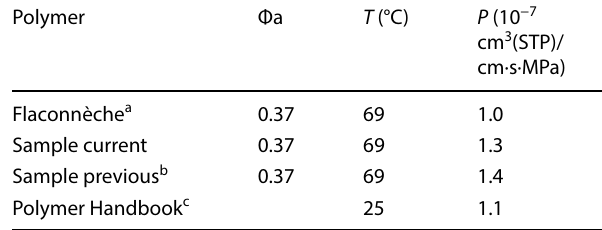
Table 2 Transport coefficients of nitrogen in pure HDPE